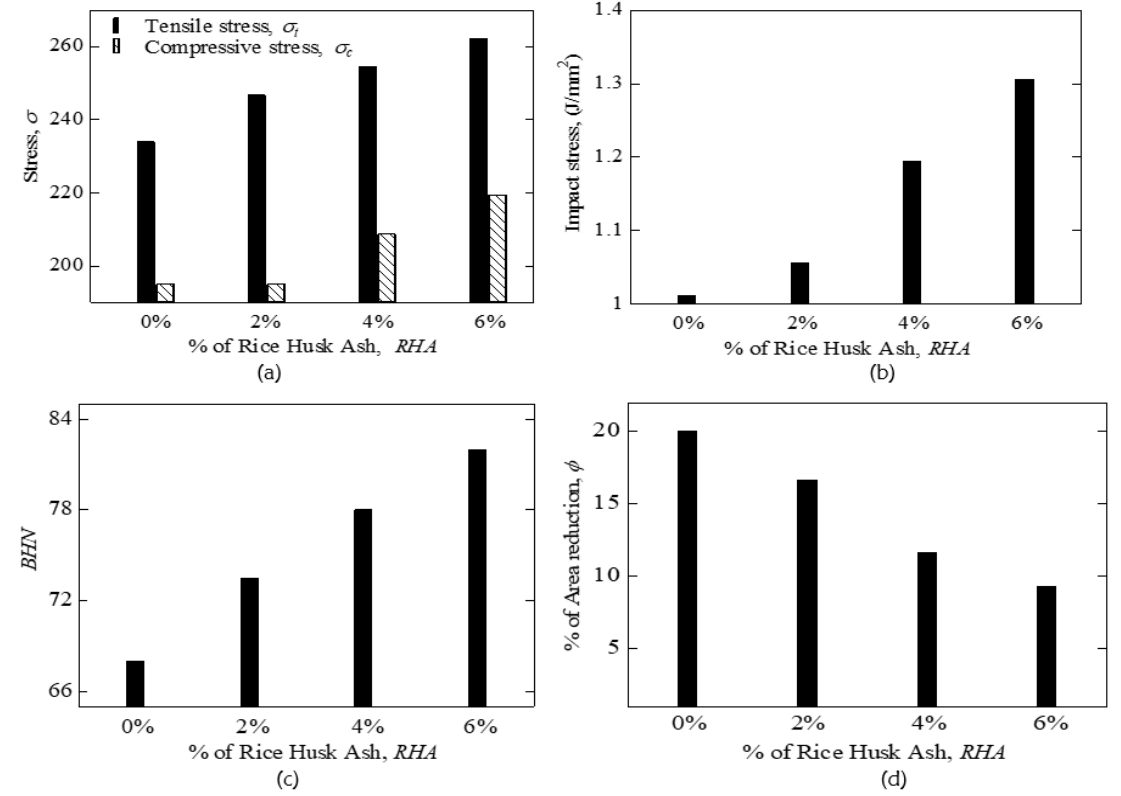
Figure 8: Mechanical properties of hybrid composites (a) tensile and compressive test, (b) impact test, (c) hardness test and (d) area reduction